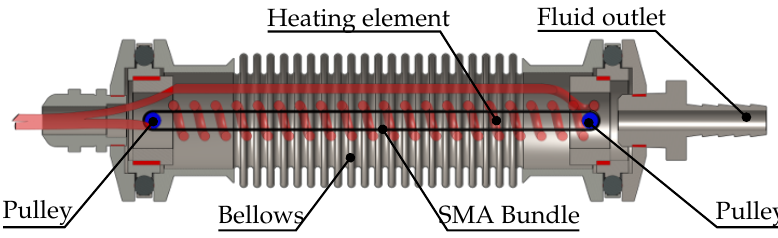
Figure 4. Zero-Flow Shape Memory Alloy Linear Actuator (ZFSMALA)